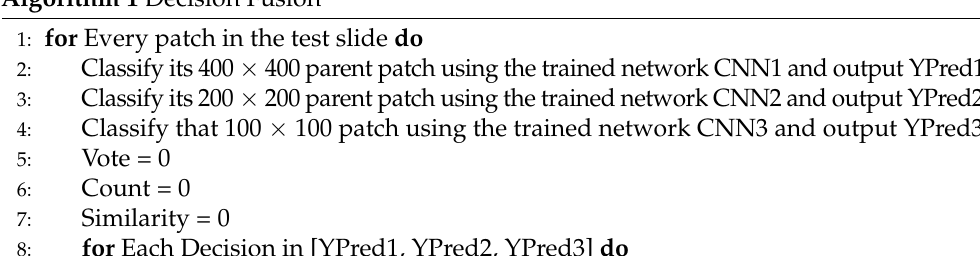
Figure 11. Demonstration of the decision fusion implementation. Algorithm 1 Decision